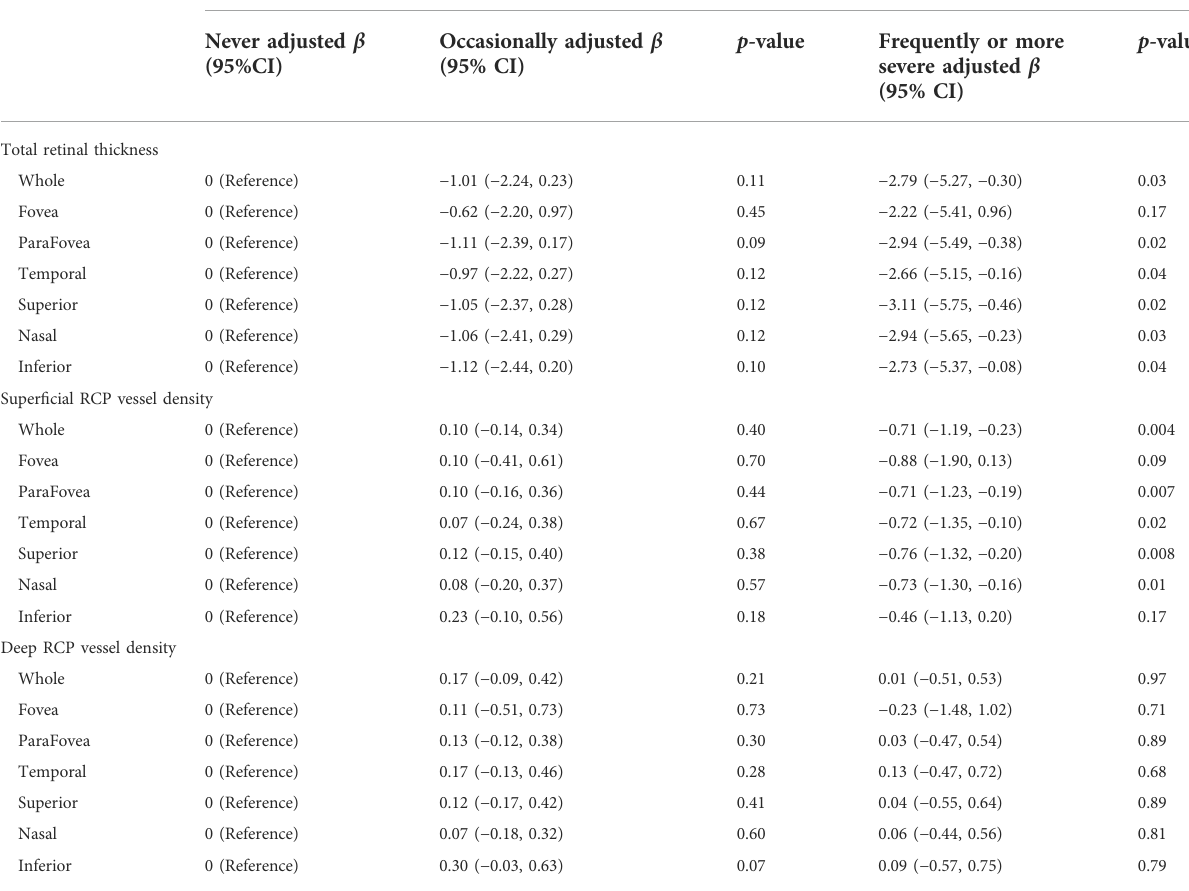
TABLE 3 Association of self-reported snoring with OCT and OCTA parameters according to frequency.